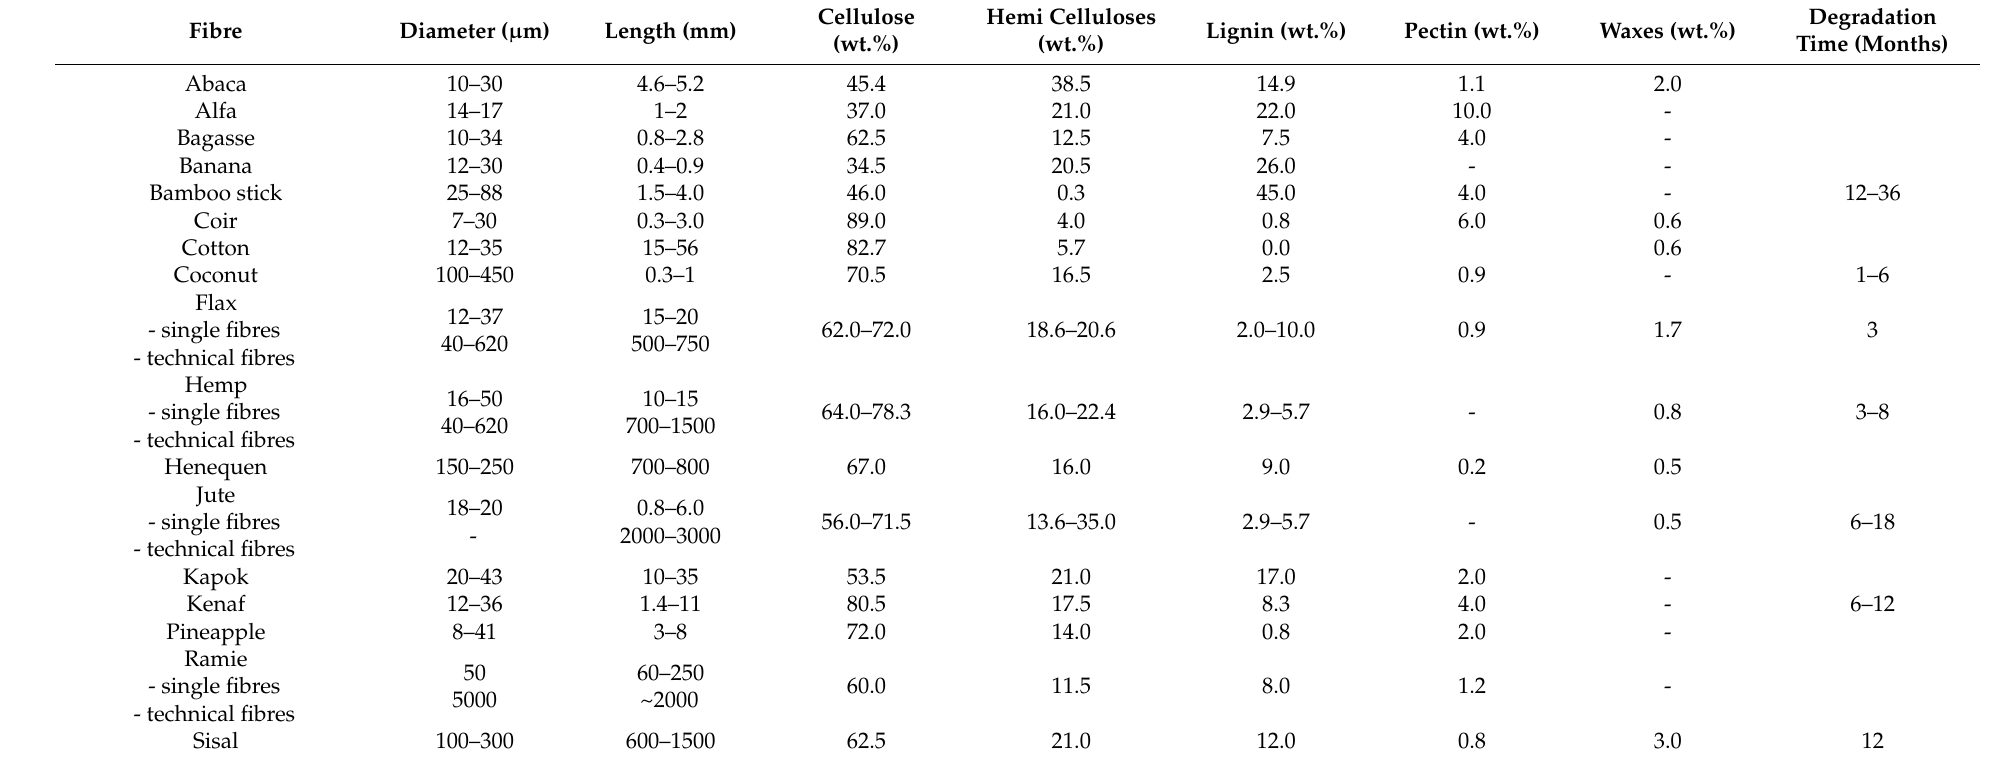
Table 2. Natural fibres physical and chemical properties with biodegradation time